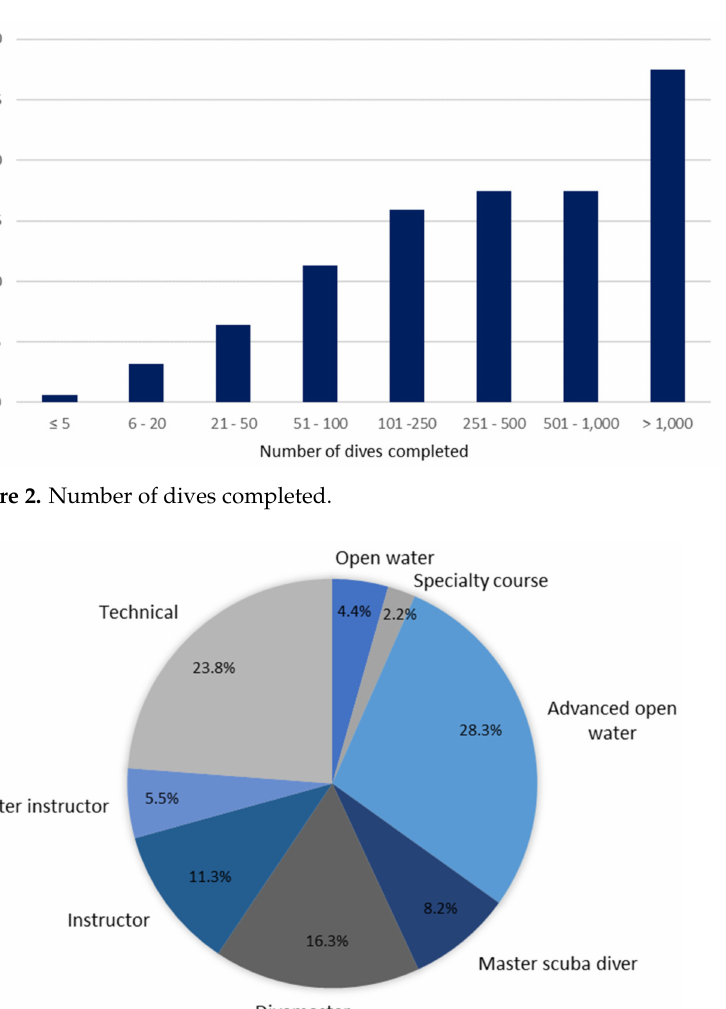
Figure 1. Country of residence.